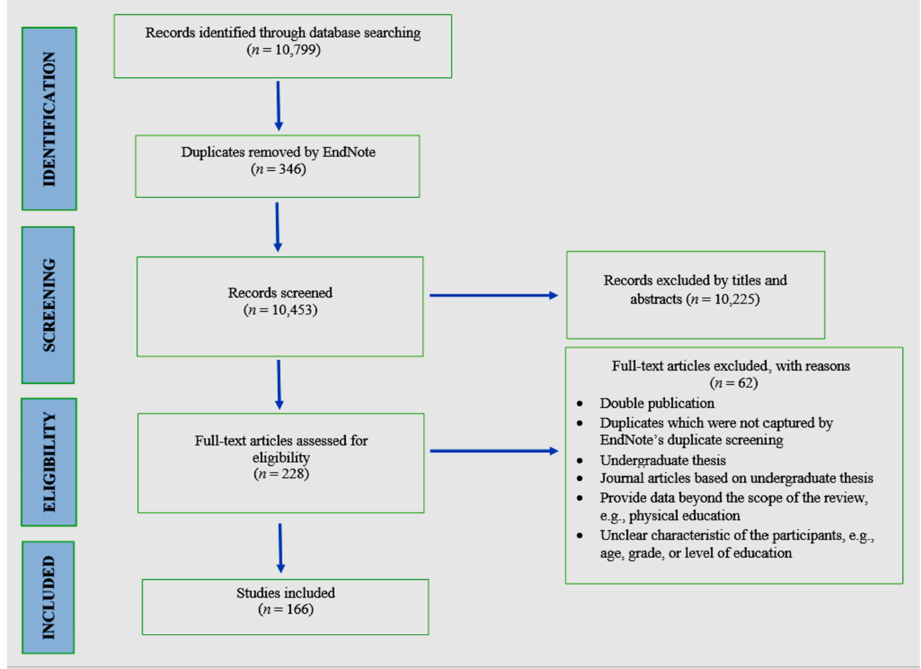
Figure 1. Flow diagram of the study screening